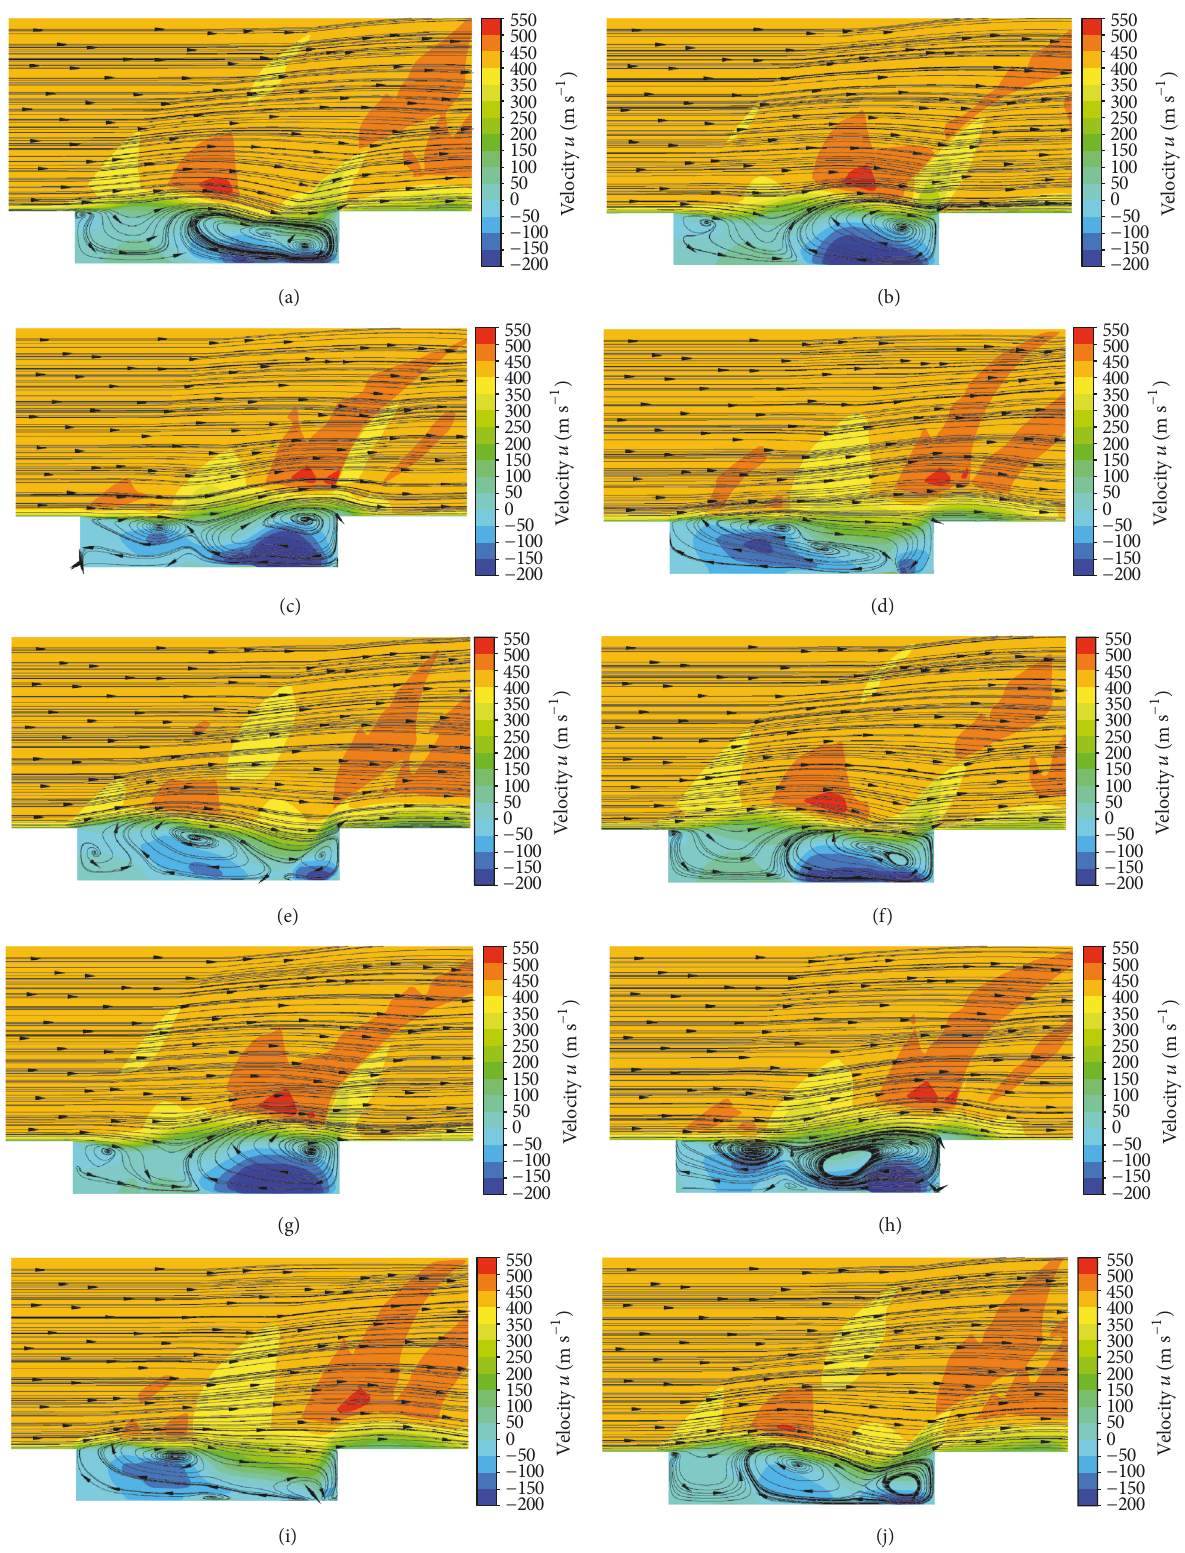
Figure 8: Contours of velocity in streamwise direction and streamlines for the baseline case (a) 𝑡/𝑡 𝑅 = 0 , (b) 𝑡/𝑡 𝑅 = 0.11 , (c) 𝑡/𝑡 𝑅 = 0.22 , (d) 𝑡/𝑡 = 0.33 , (e) 𝑡/𝑡 = 0.44 , (f) 𝑡/𝑡 = 0.55 , (g) 𝑡/𝑡 = 0.66 , (h) 𝑡/𝑡 = 0.77 , (i) 𝑡/𝑡 = 0.88 , and (j) 𝑡/𝑡 𝑅 𝑅 𝑅 𝑅 𝑅 𝑅